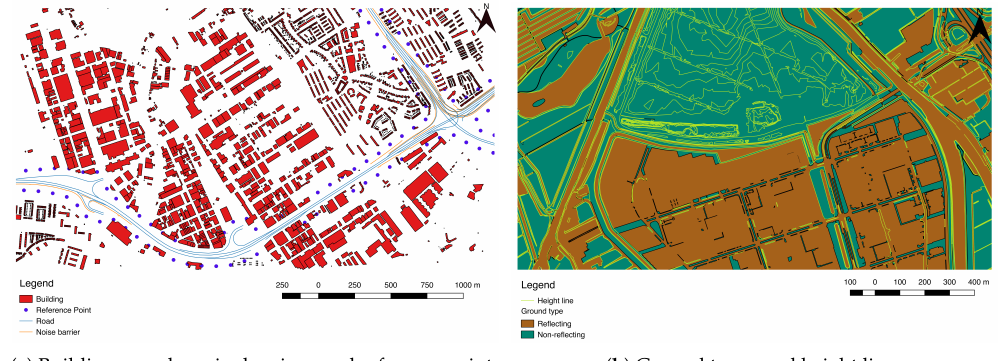
Figure 9. Input data used for testing the ADE.